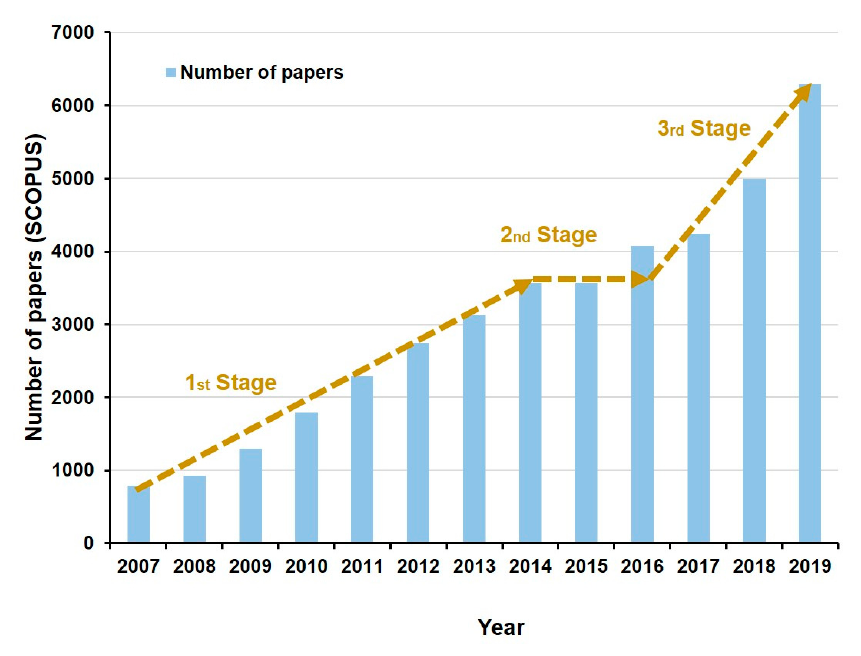
Figure 5. Wind energy O&M research evolution.